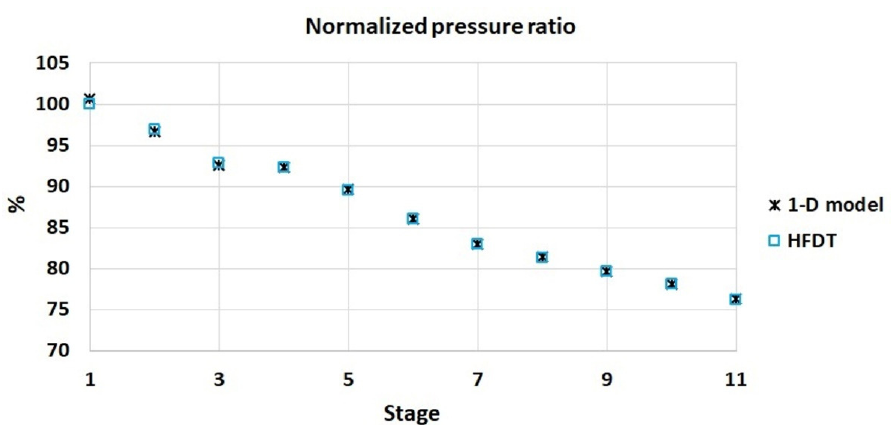
Figure 3. Comparison between stagewise pressure ratio from the 1-D model and HFDT at design point and 100% ω max .